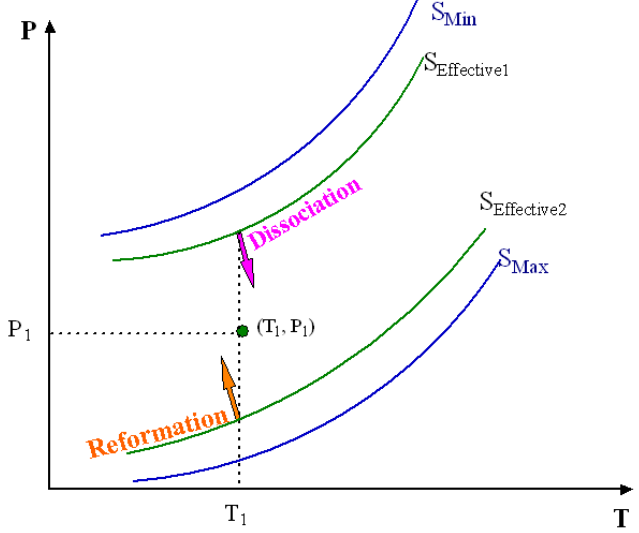
Figure 11. Schematic diagram of methane hydrate dissociation boundary shift in the decomposition process (S Min , S Max , and S Effective are the min, max, and effective pore size, respectively).